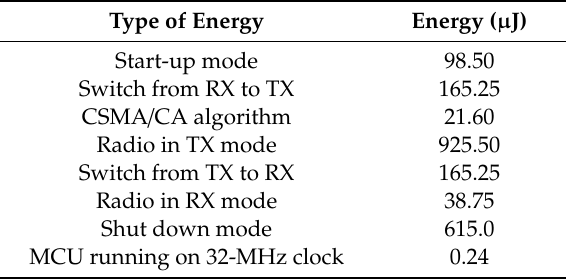
Table 5. Obtained energy model for the WiFi sensor node